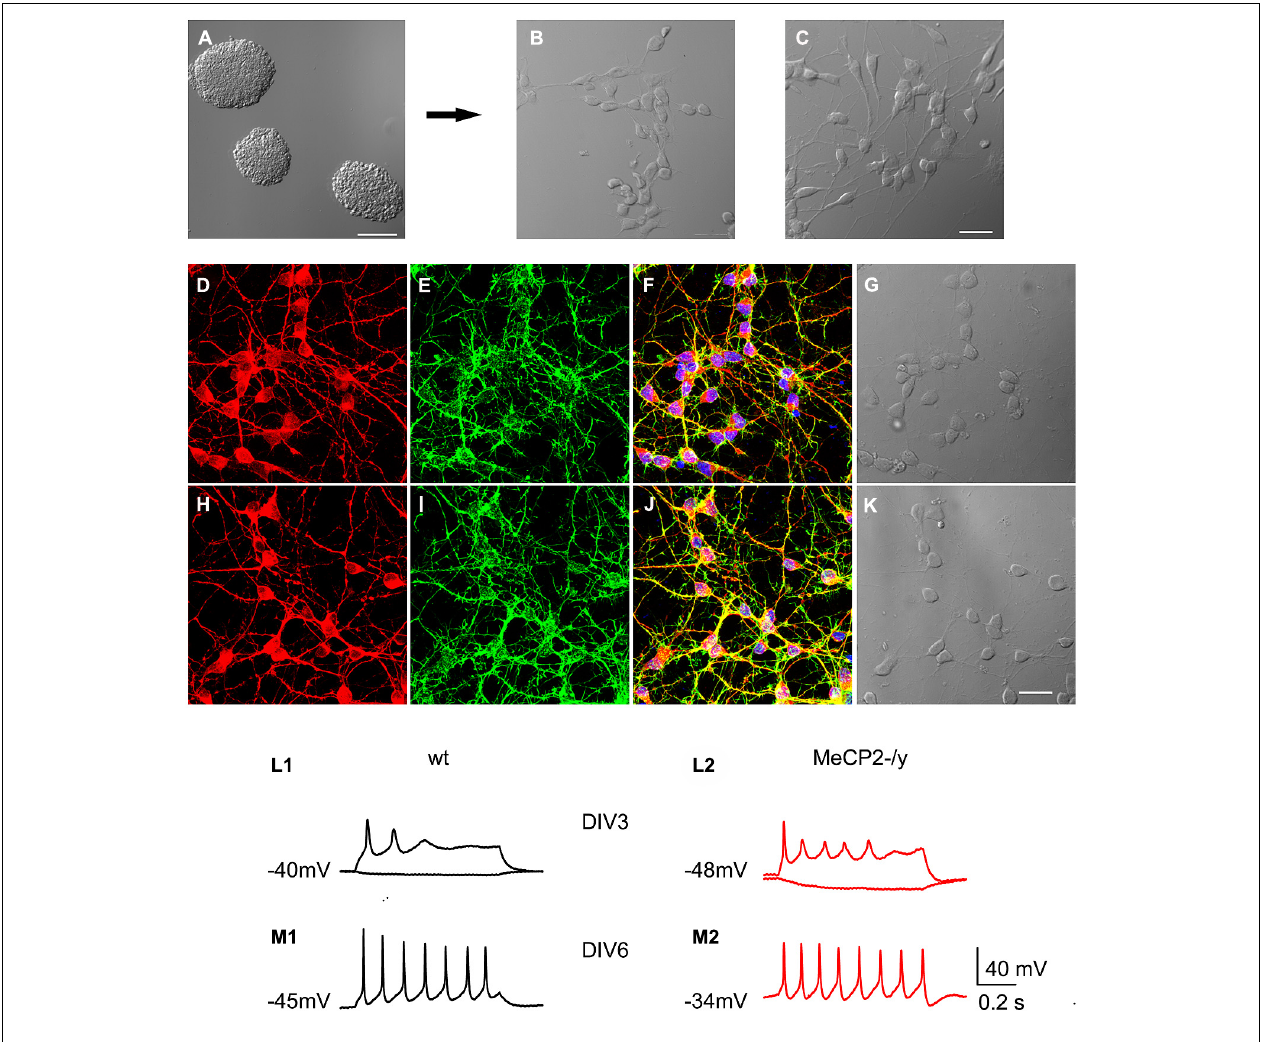
FIGURE 1 | mES cell-derived neurons show early maturation. (A–C) DIC images of early neuronal differentiation in stem cell-derived cultures. (A) Image of embryoid bodies before dissociation; scale bar: 100 μ m. Progenitor cells 6 h afterplating (B) and at DIV 1 (C) ; scale bar: 20 μ m. Immunostainings against doublecortin (D) , actin staining with phalloidin (E) . (F) Overlay of doublecortin and phalloidin stain with DAPI stain (blue) and the corresponding DIC image (G) in wt cultures